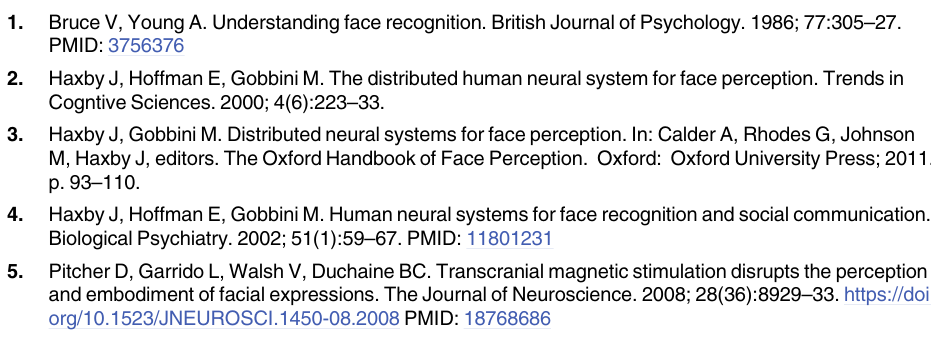
S4 Fig. Correlations: Reaction time. Correlation between reactions times on Identity task and Expression task plotted by participant age. Error bars represent 95% confidence